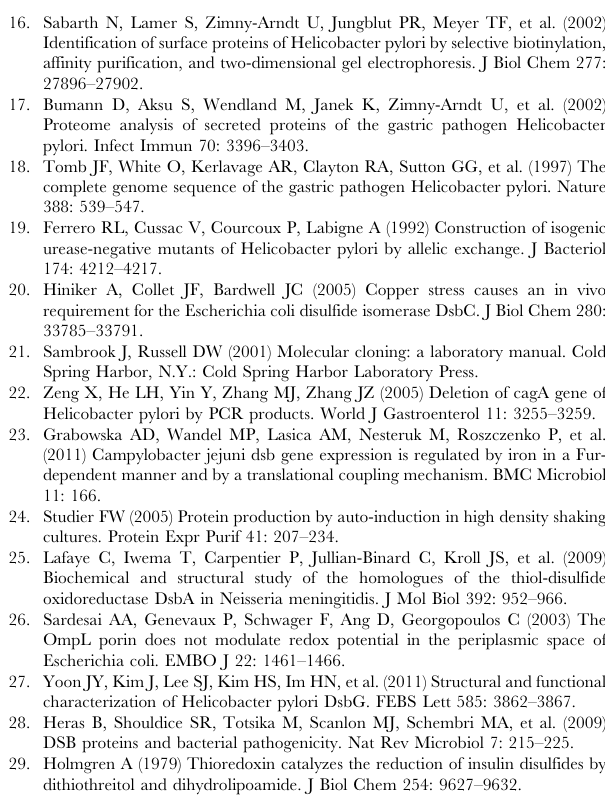
Figure S2 RT-PCR analysis of H. pylori hp0232 tran- scription from the wild-type or hp0231 :: cat mutant chromosomal DNA. Equal amounts of mRNAs isolated from H. pylori cells (wt – lane 1 and hp0231 :: cat mutant – lane 3) were reverse-transcribed using primer hp232R and the resulting cDNA was PCR-amplified with a pair of primers, hp232F and hp232R. To the control reactions (lanes 2 & 4) reverse transcriptase was not added. The relative positions of the DNA molecular length markers (lanes M) are listed on the left. (TIF) Figure S3 HP0231 does not restore the E. coli dsbC 2 wild type phenotype in the copper sensitive assays. As a negative control E. coli dsbC :: aph was transformed with an